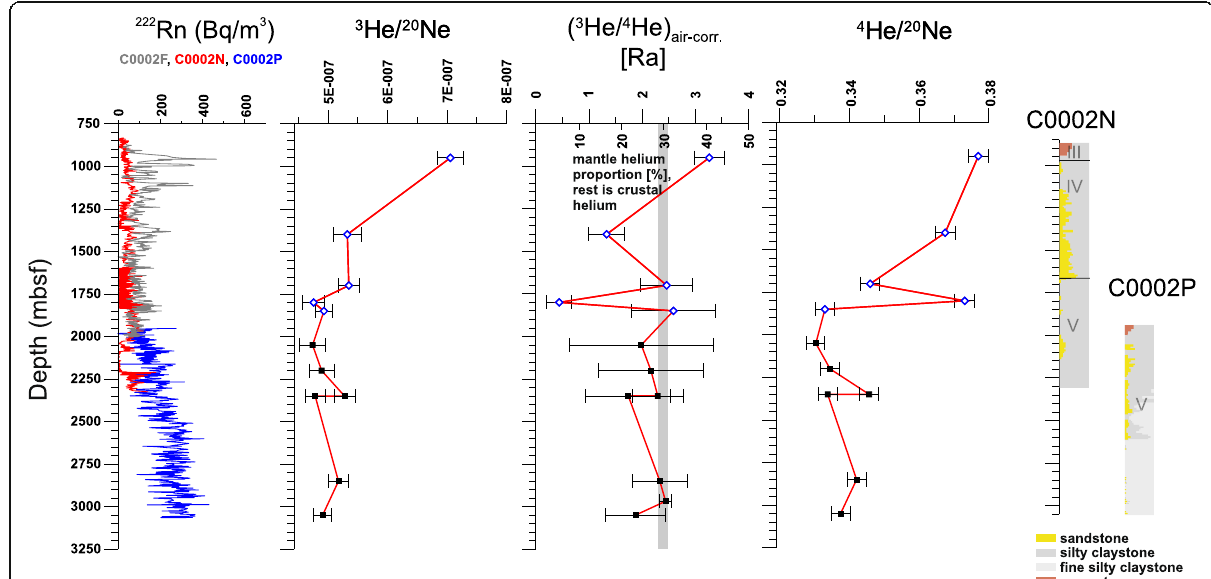
Fig. 4 Depth profiles for 222 Rn 3 He/ 20 Ne, air-corrected 3 He/ 4 He, and 4 He/ 20 Ne. The air-corrected 3 He/ 4 He versus depth plot also indicates the mantle contribution to the total helium in percent air-corrected (the rest would be crustal helium). Sample #2968.5 is not shown in the 3 He/ 20 Ne and 4 He/ 20 Ne profiles (see text for explanation). Samples from Exp 338 are plotted as blue open diamonds; those from Exp 348 are shown as black squares. 222 Rn data from Tobin et al.